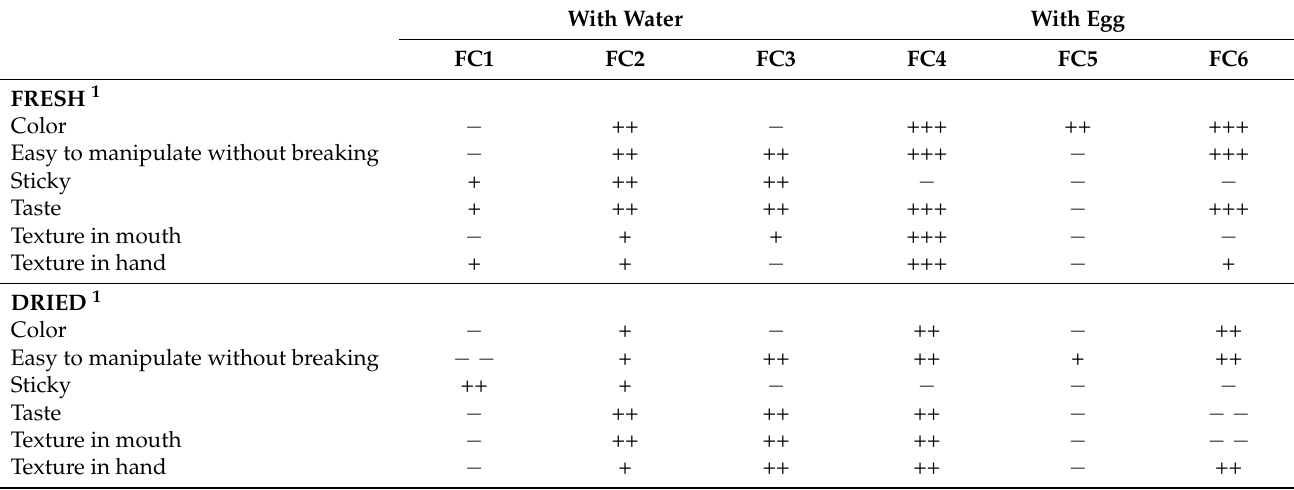
Figure 3. Production diagram for the pasta preparation. Table 1. Appreciation of the six formulations tested for the control (FC)